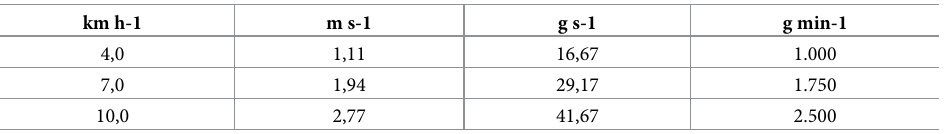
Table 1. Flow determination to simulate